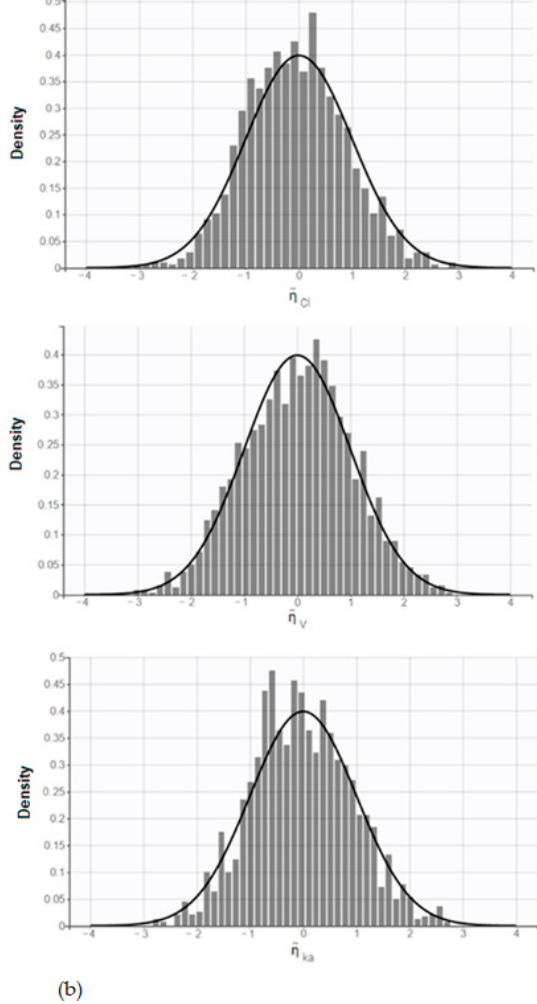
Figure 5. ( a ) Correlation between random effects; ( b ) distribution of random effects. Table 2. Selection of target